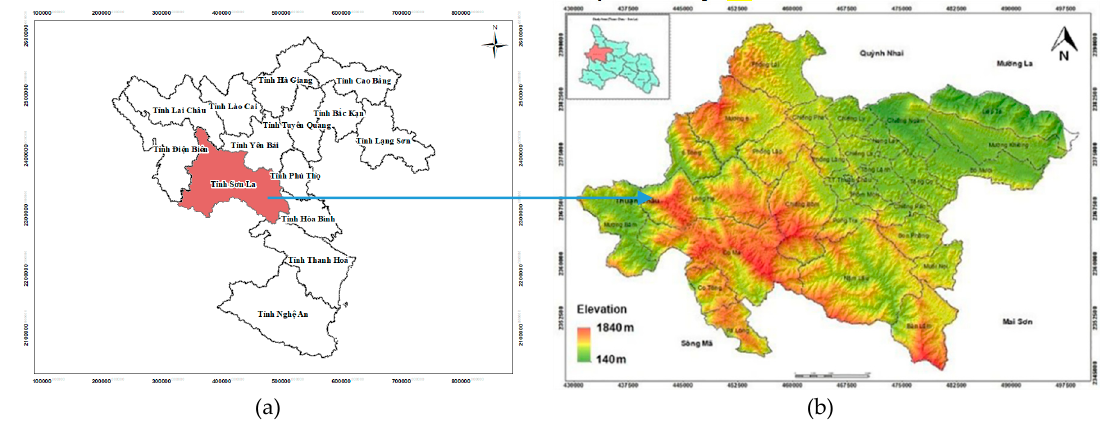
Figure 1. (a) Position of Thuan Chau district and (b) digital elevation model (DEM). Figure 1. ( a ) Position of Thuan Chau district and ( b ) digital elevation model